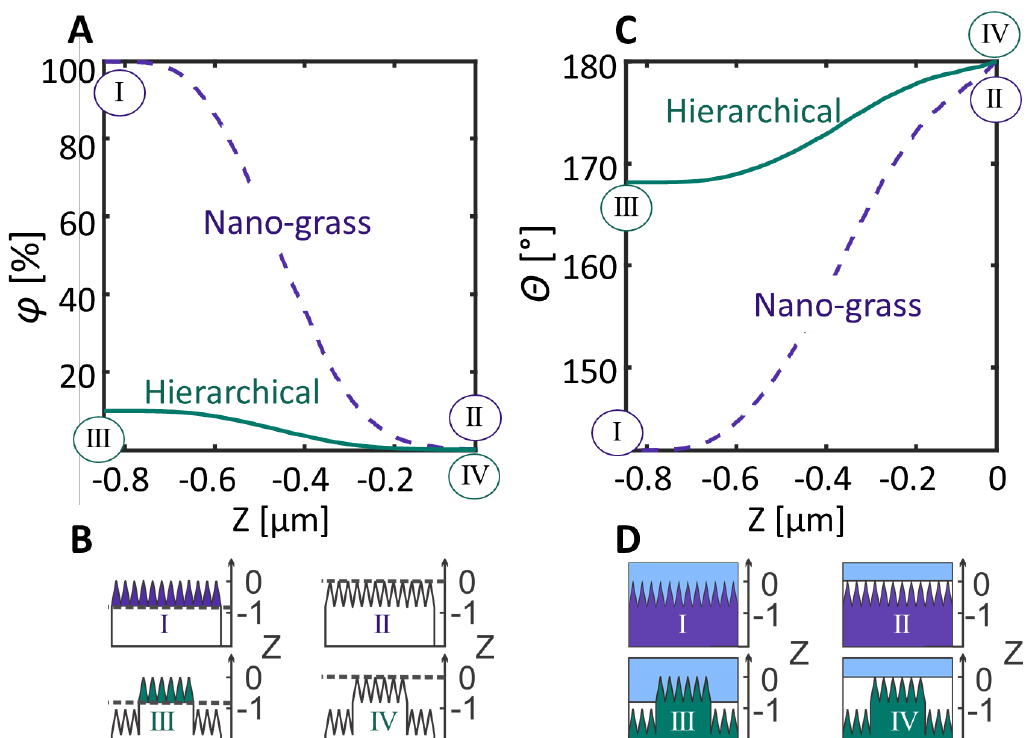
Figure 3. The estimation of the wetting by using the modified Cassie-Baxter equation. ( A ) The filling factor 𝜑 (projection of the wetted area/total area) as a function of the wetting depth 𝑍 (note, the zero-value is set to the top of the pattern); the values are obtained from the atomic force microscopy (AFM) measurements of the structures. ( B ) A schematic of the wetting depth at the points marked in the graph. ( C ) The expected contact angle at different wetting depths, 𝑍 (zero value is zero at the top here as well). ( D ) A schematic of the process in C.